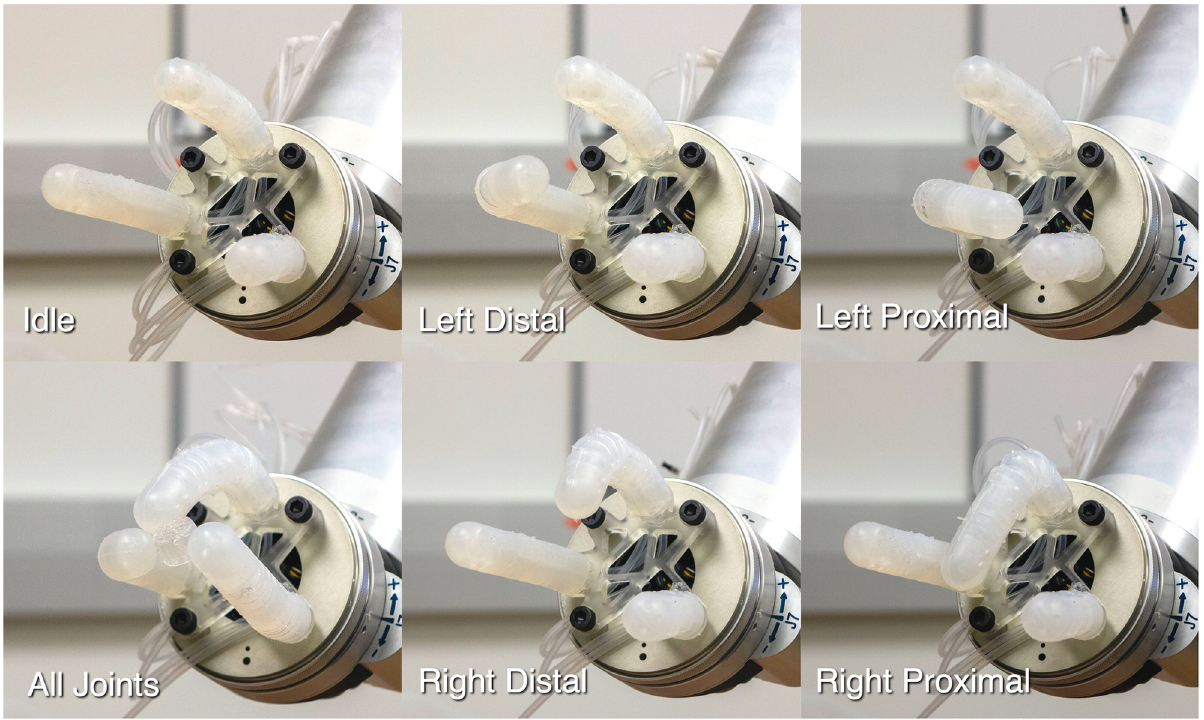
Fig 16. Pressurization of each joint of the gripper. (Top-leftmost) The gripper in its un-pressurized, idle state. (Bottom-leftmost) All joints being pressurized at once. (Right four photographs) A series of photographs showing each joint of two of the gripper’s fingers pressurized.